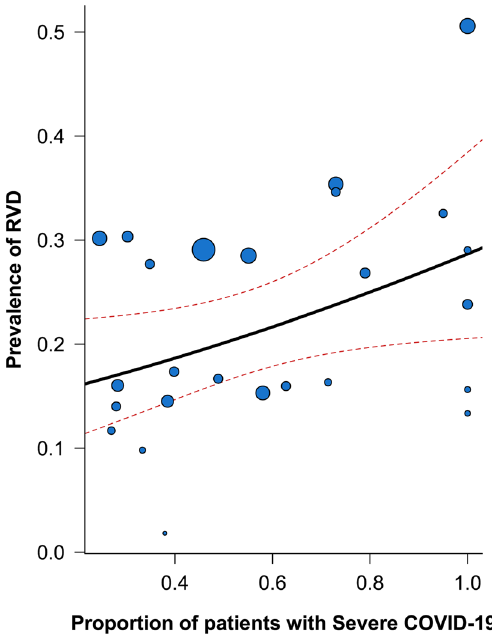
Figure 2. Meta-regression analysis for the prevalence of RVD according to severity of COVID-19. RVD right ventricular dysfunction.